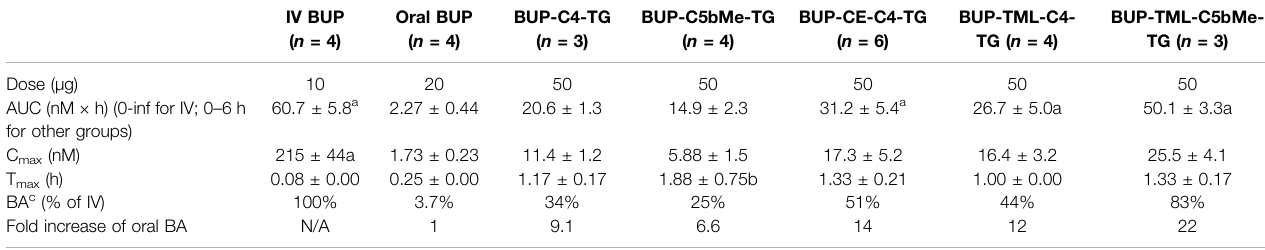
TABLE2| SummaryofPKparametersfollowingoralgavageorIVinfusionofformulationstoconscious,carotidarterycannulatedrats.Dosesarenormalizedtoa0.06 mg/kg equivalent dose of BUP. Data are presented as Mean ± SEM.